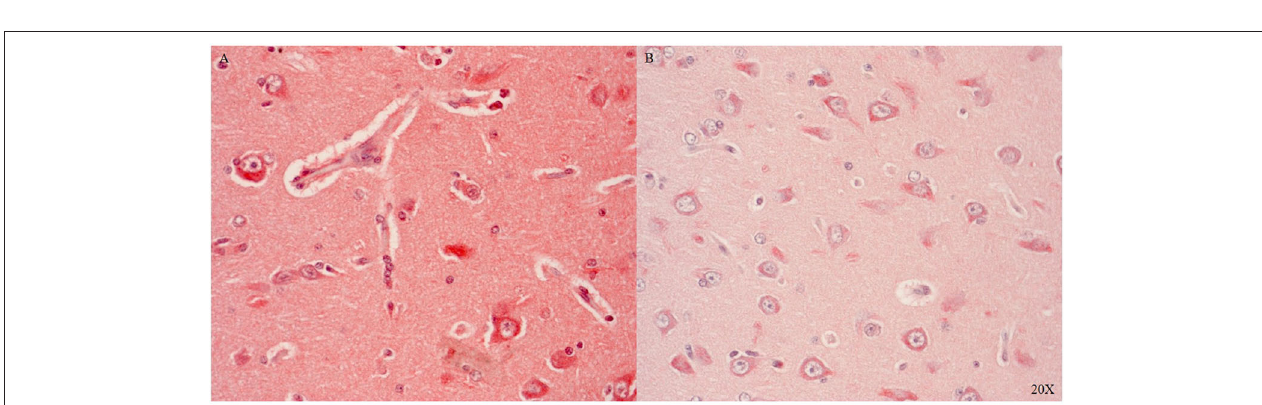
FIGURE 7 | Il-6R expression in the parietal cortex in proximity (A) and distant to the injury (B) ( n = 1). Il-6R expression in neurons, immune cells, parenchyma and the microvasculature close to the injury (A) , and limited neuronal cytoplasmic expression distant to the injury (B) . Il-6R, interleukin 6